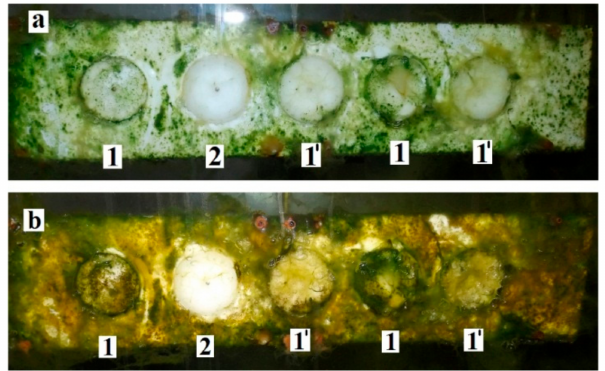
Figure 5. Microbial growth after four ( a ) and six ( b ) months of exposure in a Black Sea aquarium on vulcanized siloxane coatings, cross-linked with: (1) 6 wt % conventional cross-linker, ES40 (control); (2) 6 wt % PEG-silane instead of 6 wt % ES40; (1’) 4 wt % ES40 + 2 wt %